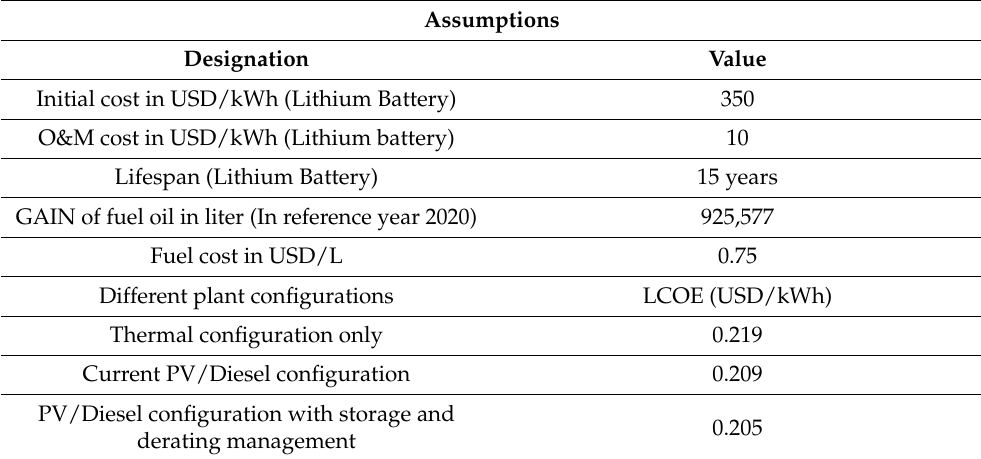
Table 12. Economic calculation assumptions for Lithium batteries [34] and comparative summary of LCOE of the